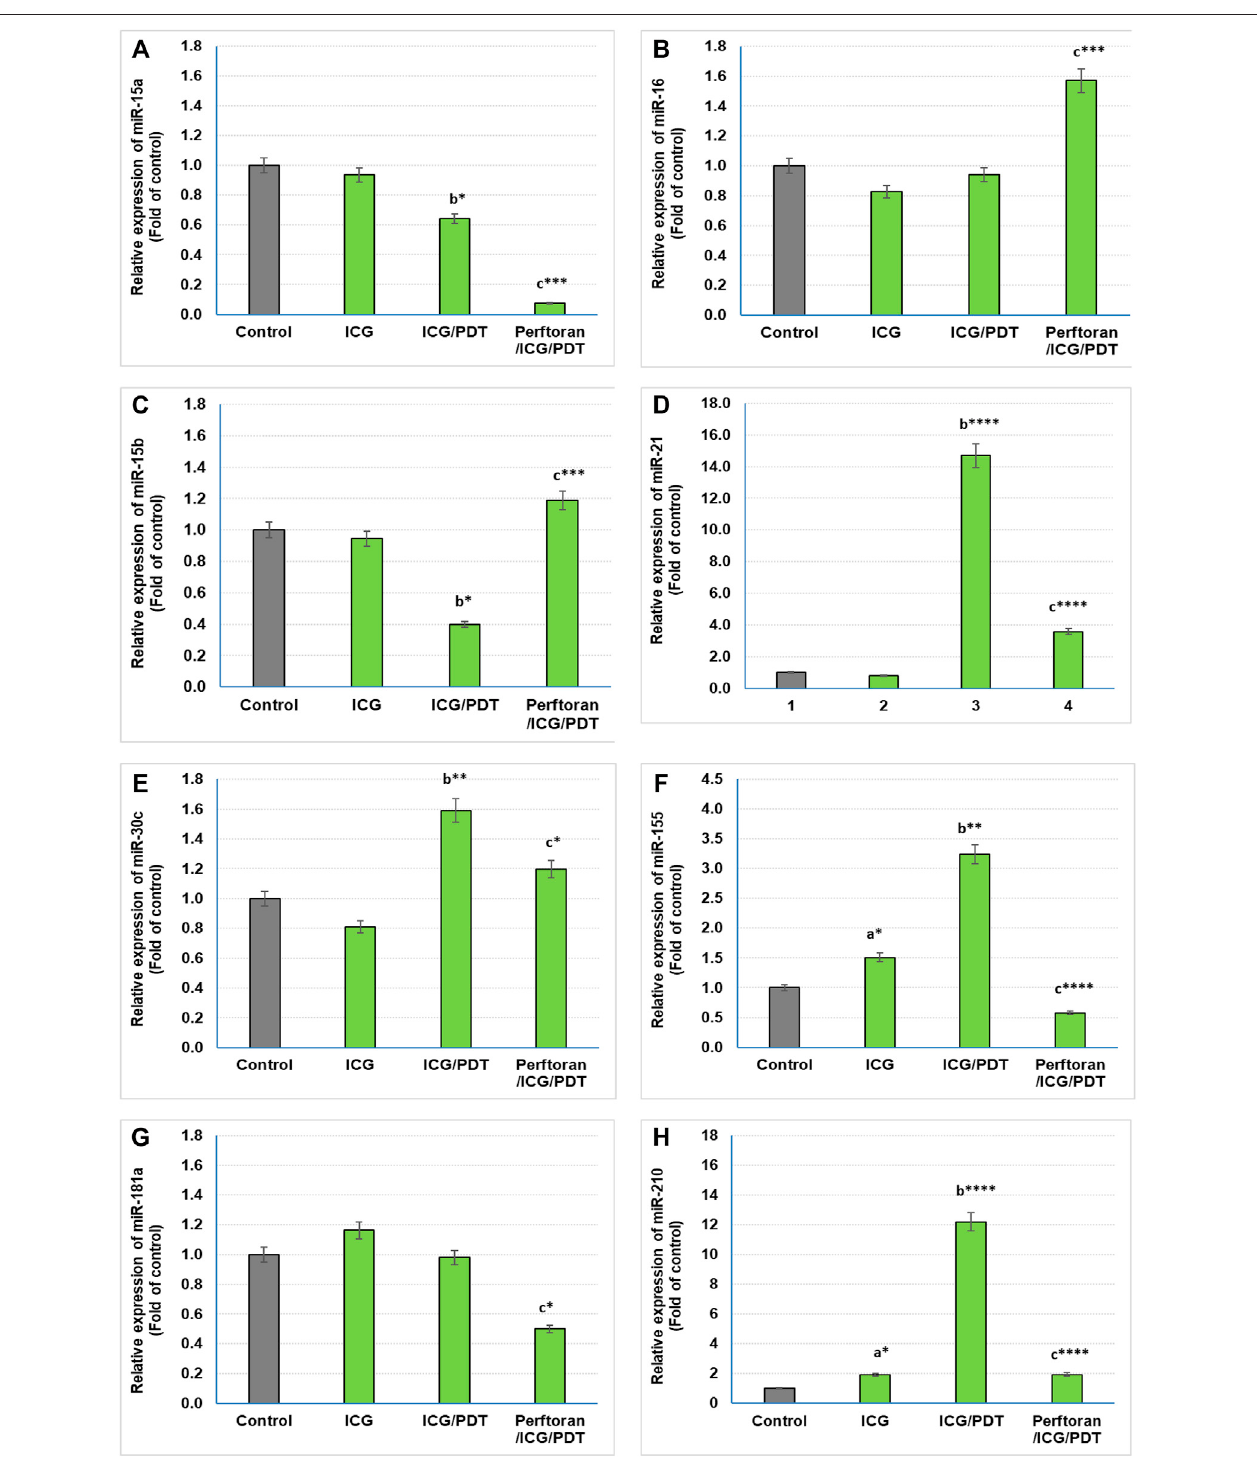
FIGURE3| ExpressionoftumorsuppressormiRNAs (A,B) andoncogenicmiRNAs (C – H) :RelativeexpressionofmiRNAswasestimatedbyqRT-PCR.Theresults are expressed as fold of control. The results were compared to those of a control cells, b ICG-treated cells, and c ICG/PDT-treated cells; * p < 0.05, ** p < 0.01, *** p < 0.001, and **** p < 0.0001.